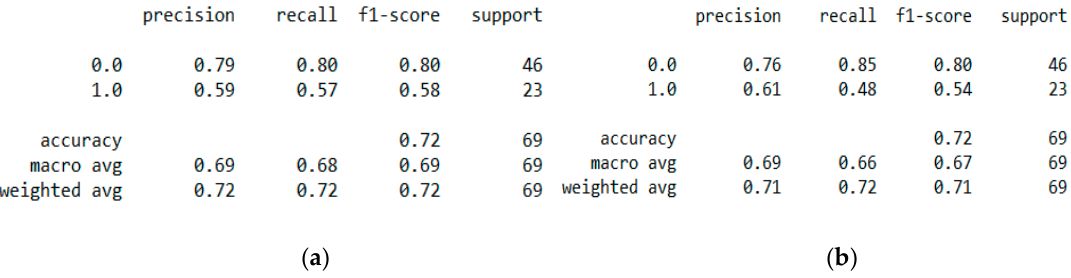
Figure 17. Correlation heatmap and classification accuracy of ML models to classify the “Cardiovascular-disease” data.